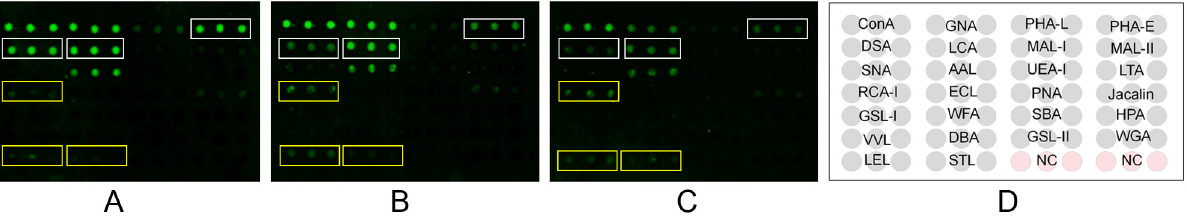
Figure 3. Lectin information in the lectin microarray.